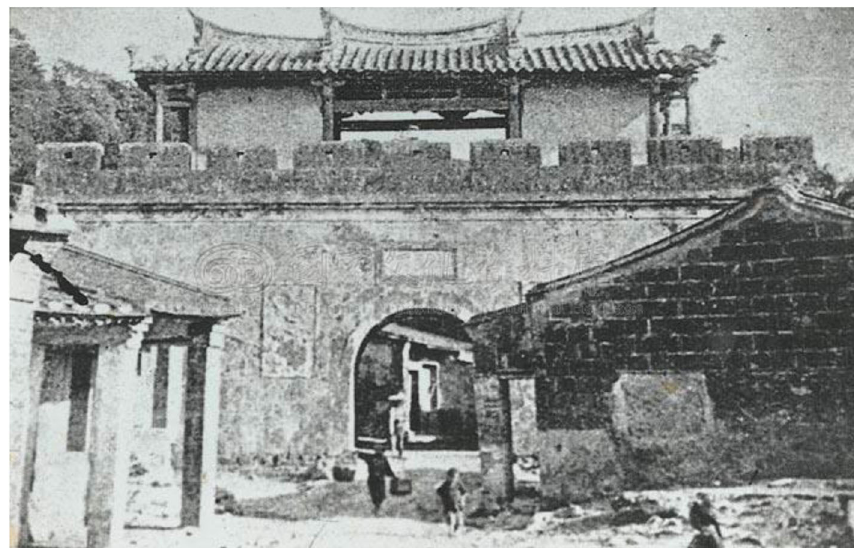
Fig. 1 The former appearance of the North Gate of Old Zuoying City (This photo was taken in 1917 and shows the representative building, the North Gate (also known as Chengong Gate), of OZC. The structure of the gate is still intact, but the buildings on top of it collapsed during the period of Japanese occupation). (Source: Taiwan Repository of Cultural Heritage. Research Center for Digital Humanities, NTU, 2010.